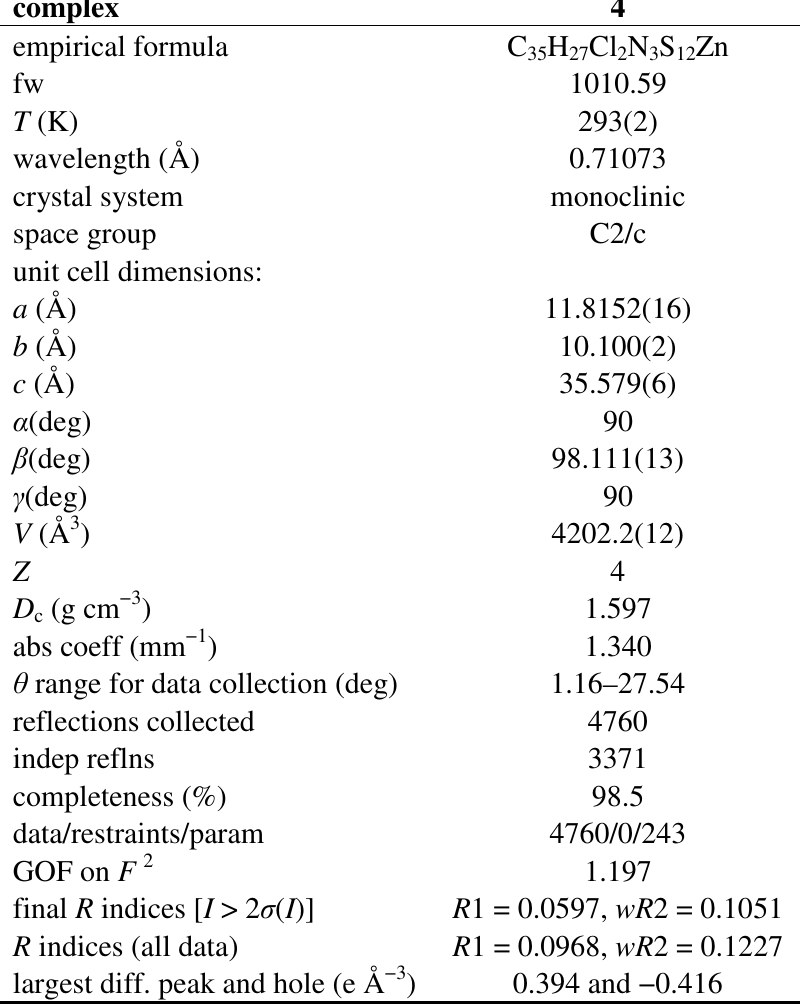
Table 2. Crystal Data and Structure Refinement for compound 4